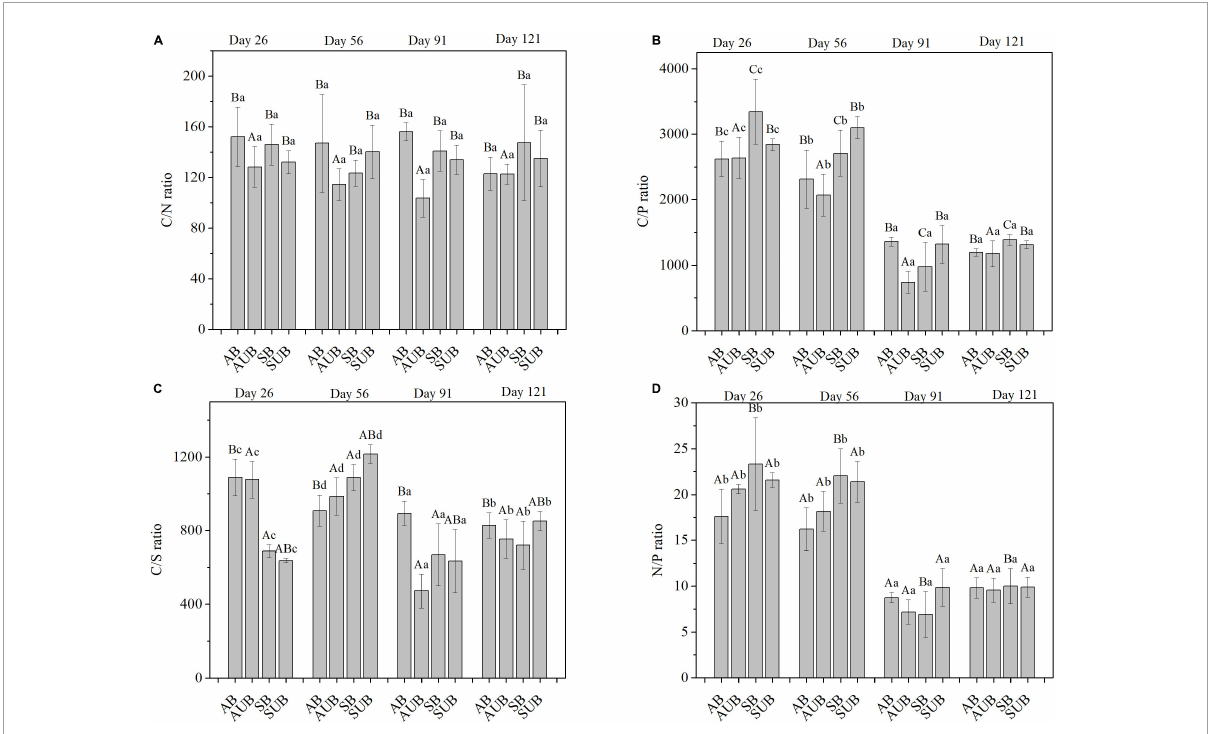
FIGURE4 The mass ratio of C/N (A) , C/P (B) , N/P (C) , and C/S (D) in residual plant litters in autumn burnt (AB), autumn unburnt (AUB), spring burnt (SB), and spring unburnt (SUB) sites. Different lowercase letters (a-d) indicate significant differences (Tukey-HSD test) among sampling times and different uppercase letters (A-C) indicate significant differences (Tukey-HSD test) between site